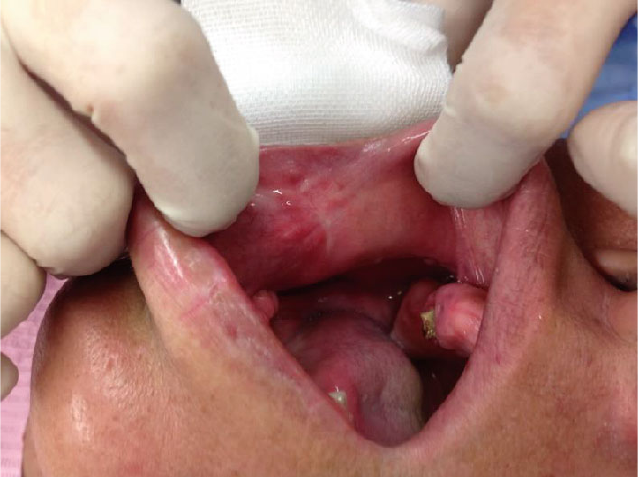
Figure 5: Postoperative intraoral. There is a scar in the mouth, but he has no trismus and no problem